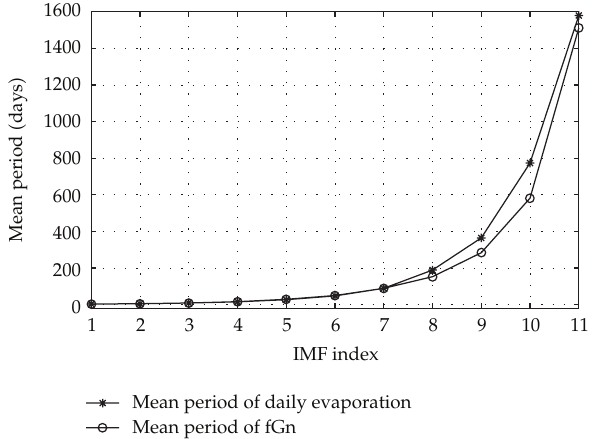
Figure 5: The mean periods of the IMFs of daily evaporation and fGn.